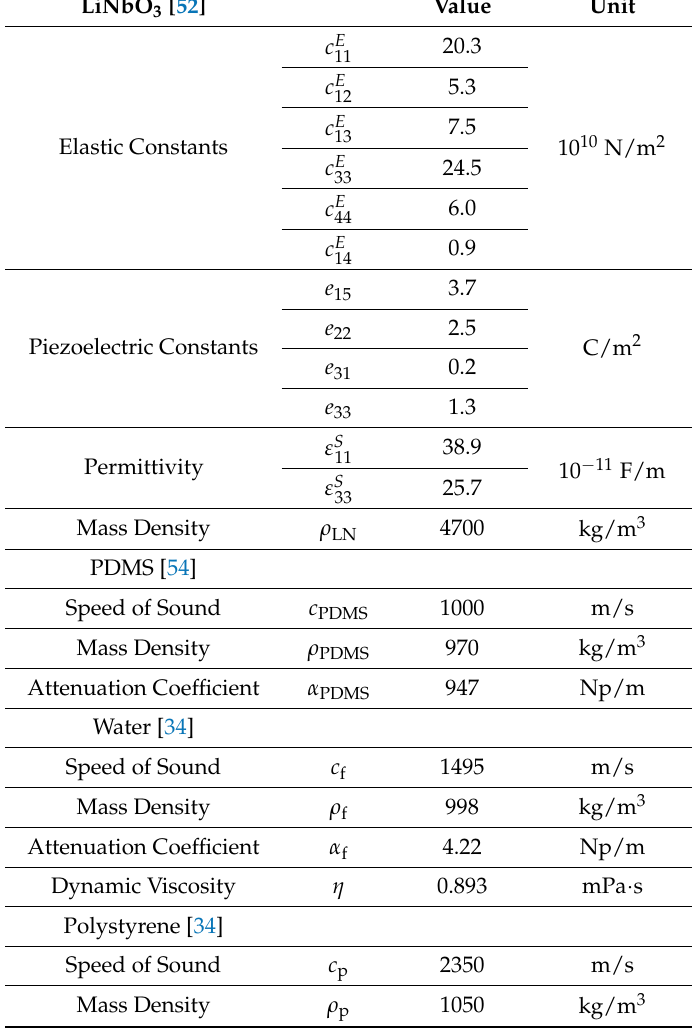
Table 2. Material parameters used in the